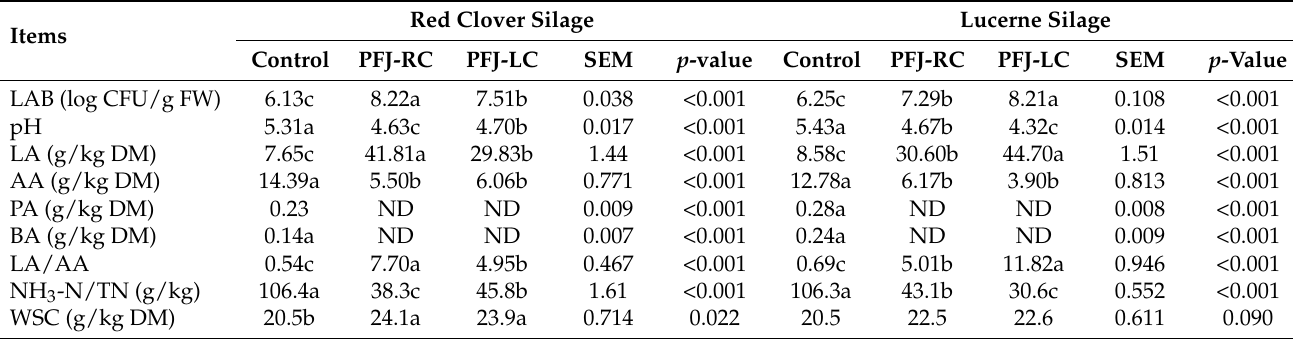
Table 4. Lactic acid bacteria (LAB) count, fermentation quality, and water-soluble carbohydrates (WSC) of red clover silages and lucerne silages (n = 3).